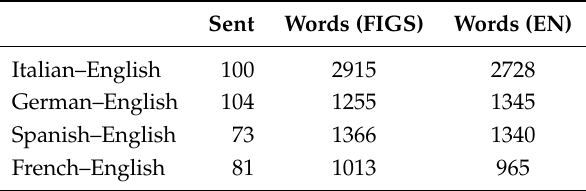
Table 3. Statistics of the “recommendations” test sets.